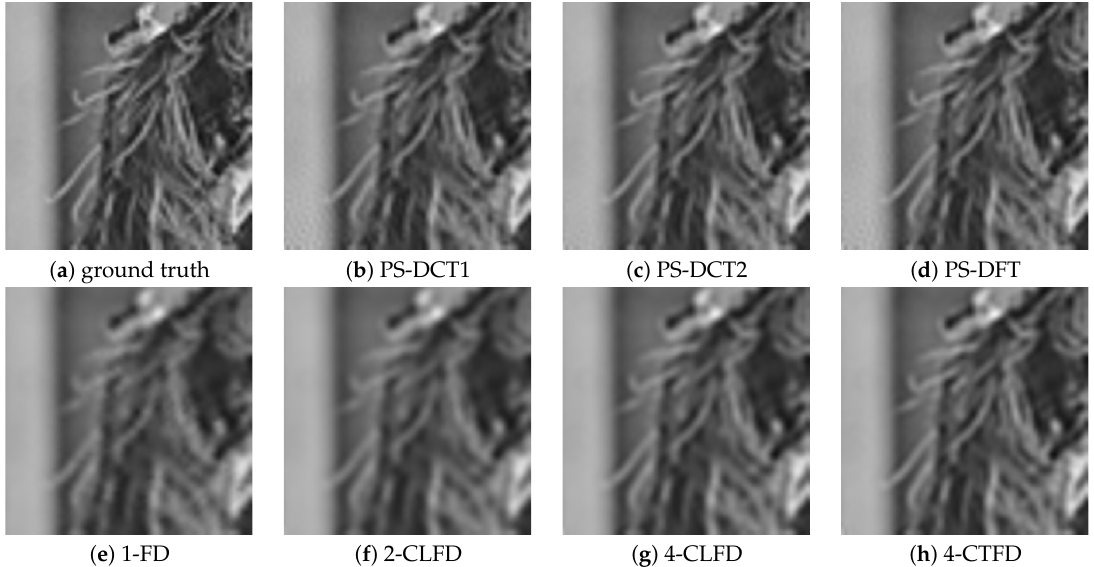
Figure 5. A portion near the circumference of the final output after successive rotation of the image “Lenna”.